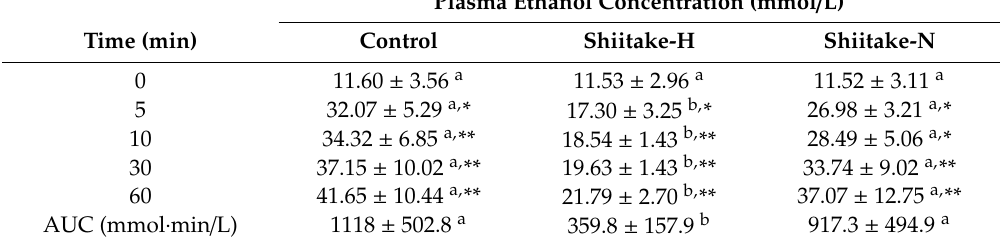
Table 4. E ff ects of shiitake extract on plasma ethanol concentration in the stomach after injection of ethanol.